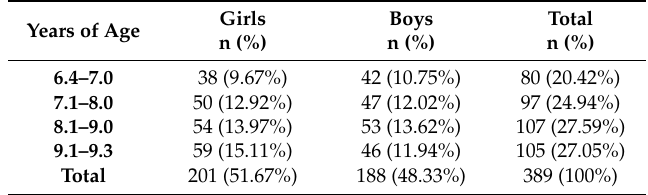
Table 2. Distribution of the study group according to age and gender.